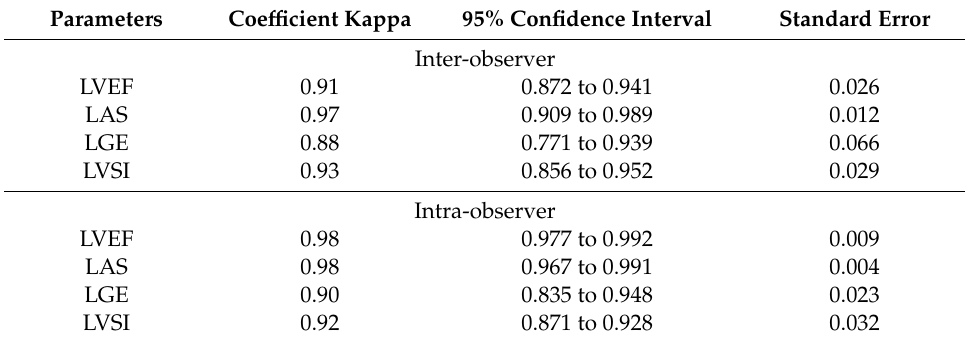
Table 2. Reproducibility inter and intra-reader agreement of cMRI